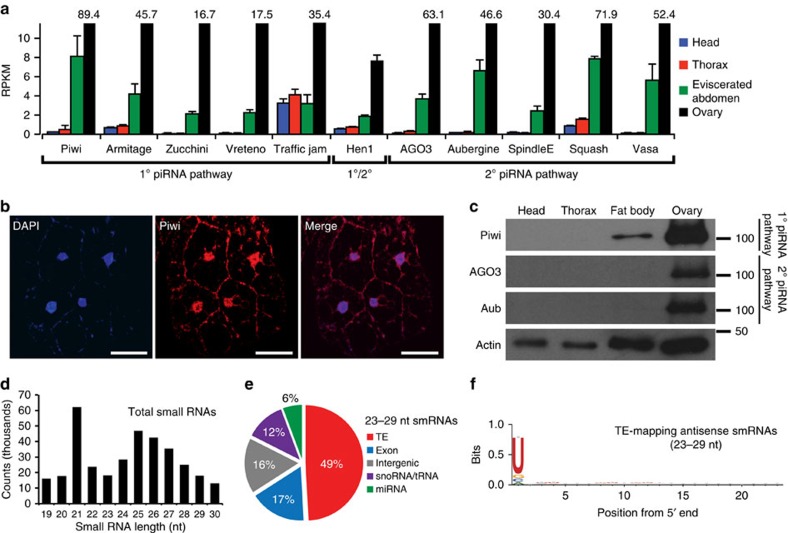
Canonical signatures of a piRNA pathway in the adult fly fat body.(a) Expression of primary and secondary piRNA pathway genes generated from total RNA-seq libraries of head, thorax, eviscerated abdomen and ovary. piRNA pathway genes are more highly expressed in the eviscerated abdomen than in the head or thorax. Data values for ovary libraries that exceed the range of the plot are shown above each relevant bar. RPKM, reads per kilobase per million. Error bars represent s.e.m.; n=3 replicate libraries. In comparing the eviscerated abdomen with head and thorax controls, 10 of 11 genes (excluding tj) are statistically significant (P<0.0001). See Supplementary Dataset 1 for statistics. (b) Piwi protein localizes to the nuclei of abdominal fat body cells. DAPI labels fat body nuclei. Staining in the membrane is autofluorescence typical of fat body cells. Scale bars represent 20 μm. (c) Piwi protein is present in the fat body. All piRNA argonautes are present in the ovary samples. Actin serves as a loading control. (d) Fat body smRNA size profile from oxidized smRNA-seq libraries. Oxidation allows for enrichment of 2′-O-methylated smRNAs. Peak at 21 nt likely represents short interfering RNA (siRNA) population. Broader peak from 23 to 29 nt represents putative fat body piRNAs. Reads aligning to rRNA and miRNA were excluded from analysis. (e) Fat body piRNAs (23–29 nt) aligned to the fly genome map primarily to TEs. (f) Sequence composition of TE-mapping fat body piRNAs (23–29 nt) displays a first position nucleotide bias for uracil.